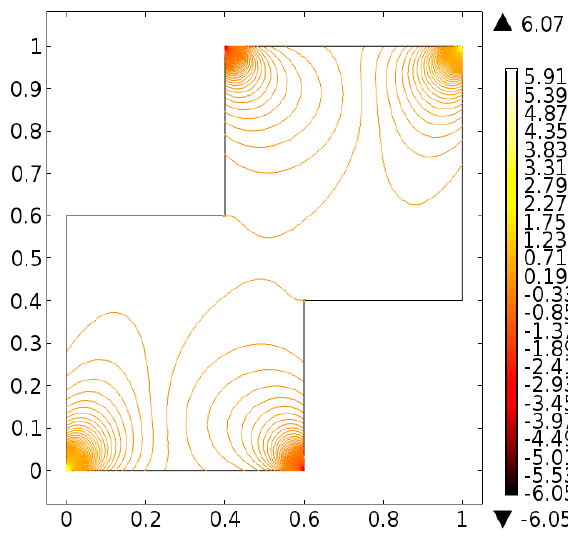
Figure 35. Pressure distribution at Re = 50 for case-III.